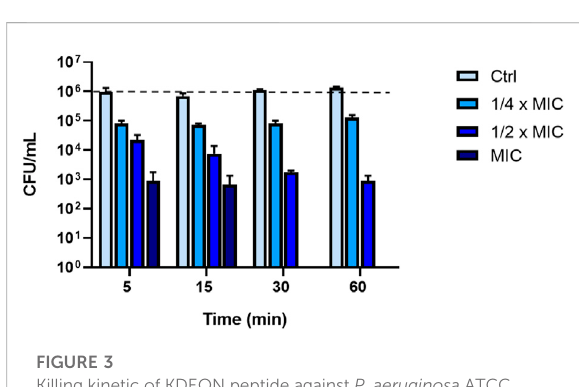
FIGURE 3 Killing kinetic of KDEON peptide against P. aeruginosa ATCC 27853 evaluated by CFU counting after 5, 15, 30 and 60 min of peptide treatment. Dotted line represents initial inoculum density. Data represent the mean ± SEM of three independent